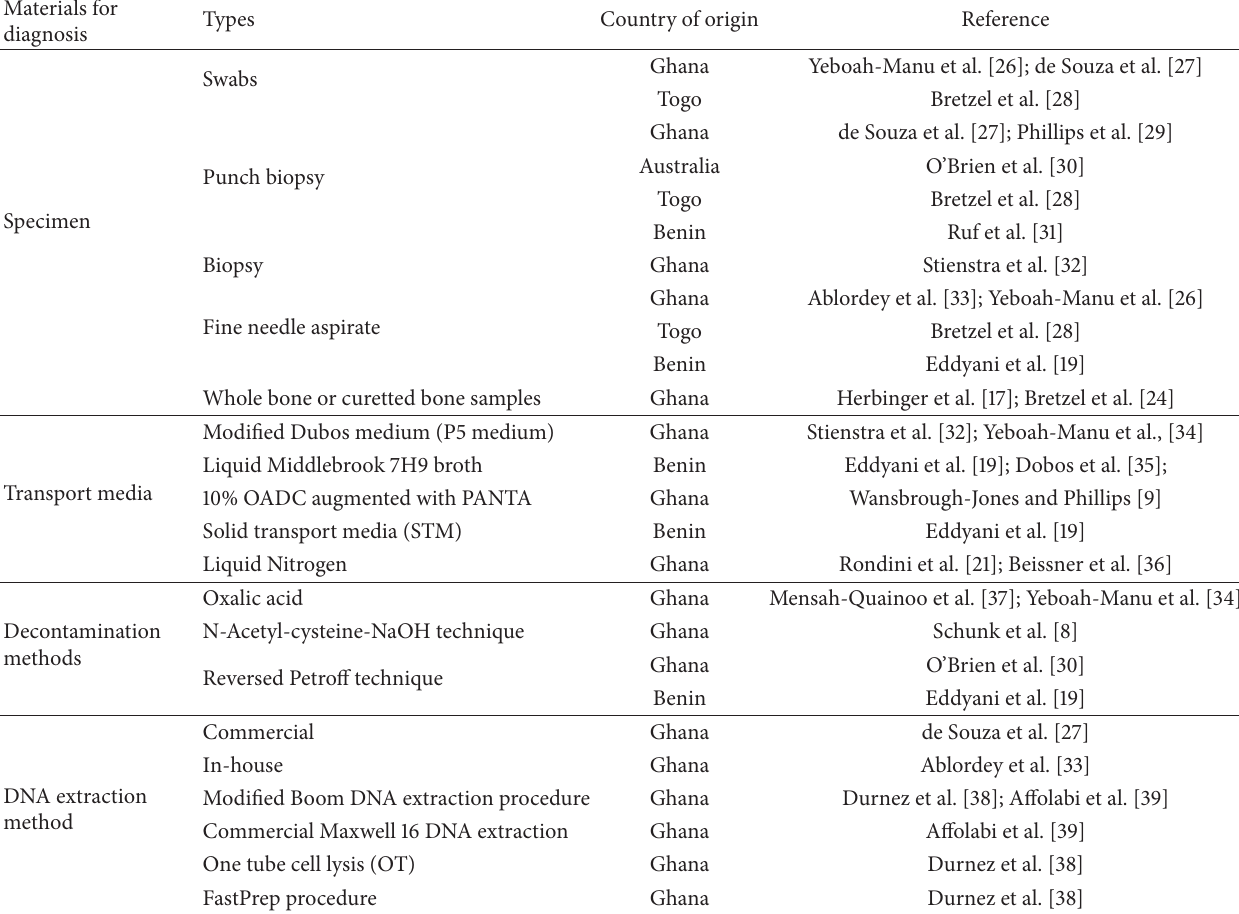
Table 1: Summary of types of specimen and transport media for BU